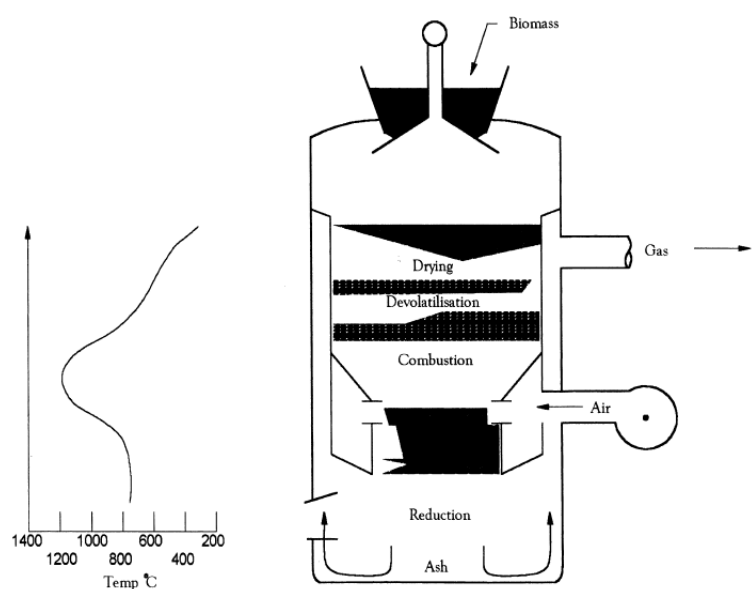
Figure 4. Schematic of a downdraft gasifier